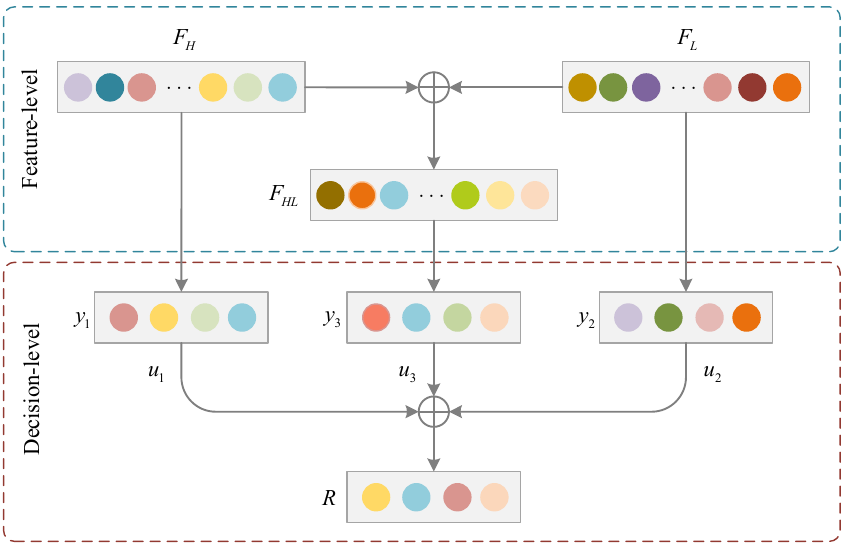
Figure 4. Structure of fusion strategy.